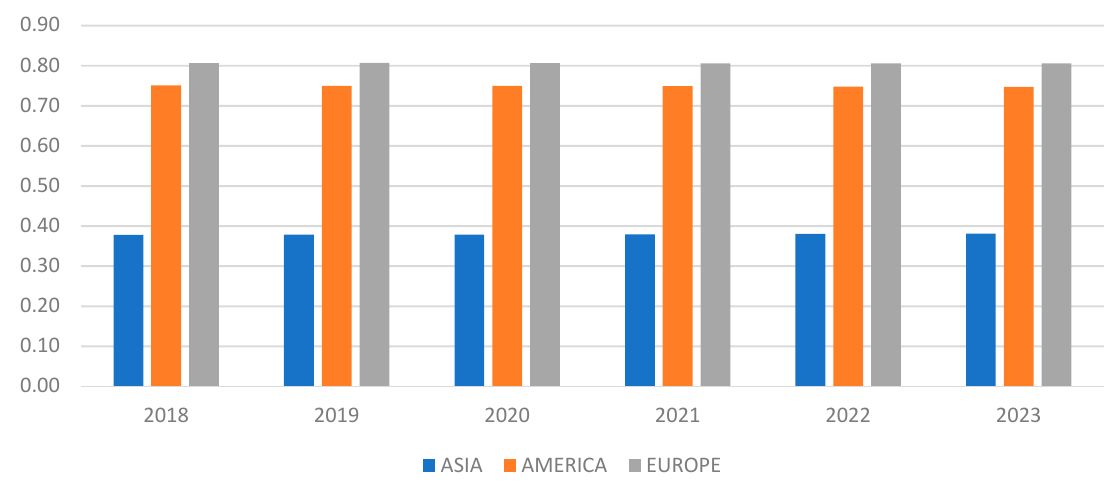
Figure 6. Efficiency score from 2018 to 2023.